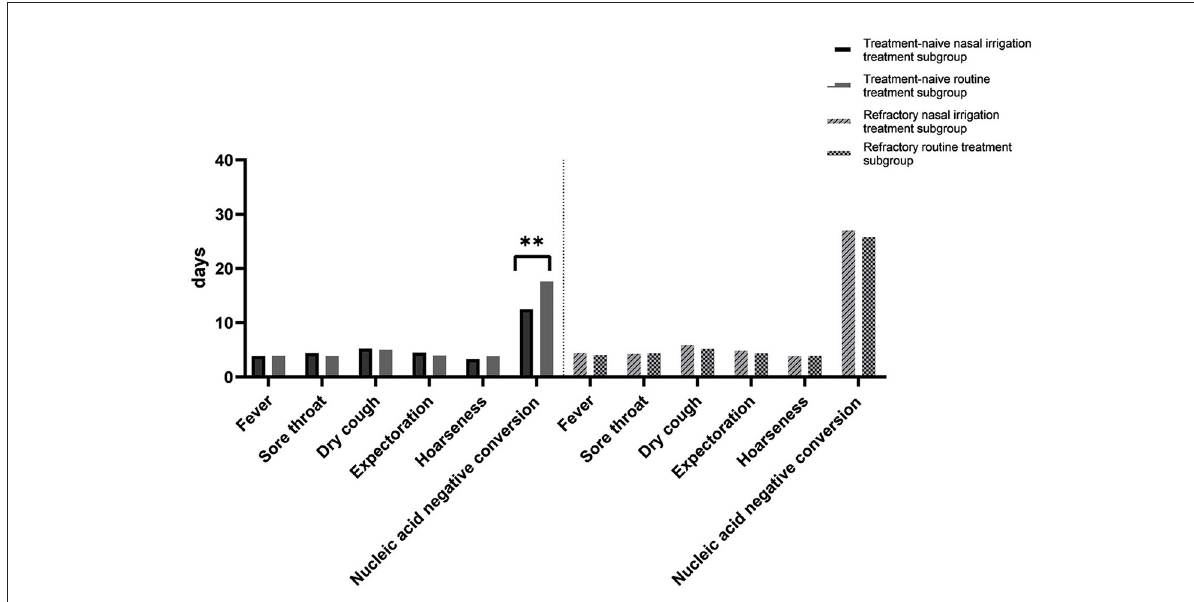
FIGURE2 Time to the disappearance of symptoms and conversion of nucleic acids. Between the naïve and refractory subgroups. ** P < 0.01.